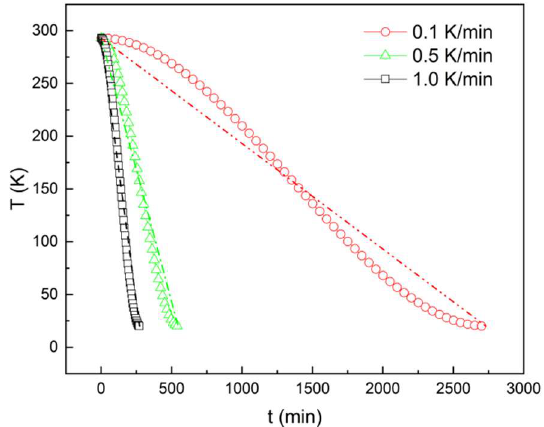
Figure 4. Temperature distribution at the average cooling rates of 0.1 K/min, 0.5 K/min, and 1 K/min.